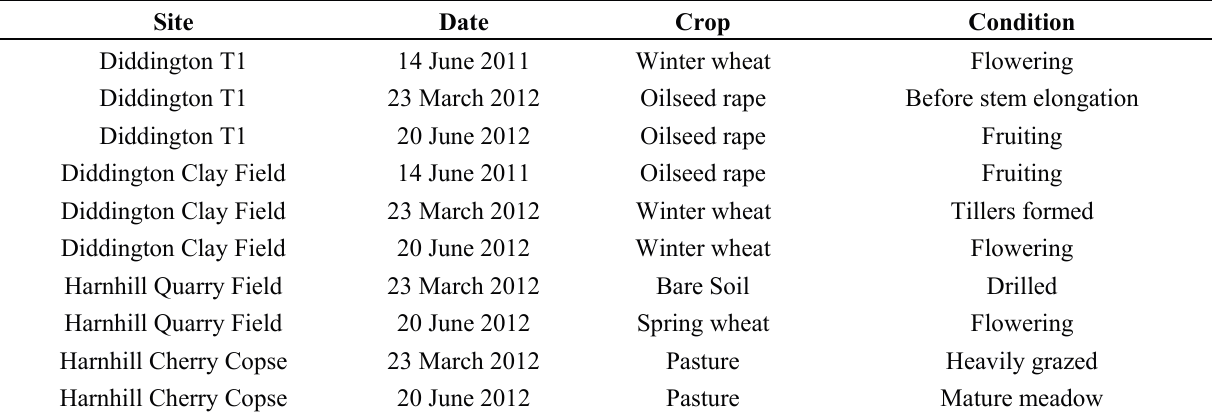
Table 2. Condition of the state of the crop at each field study site during data